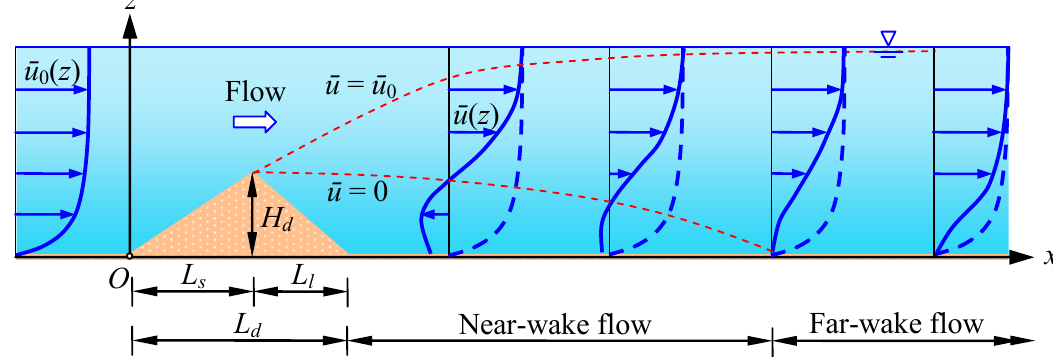
Figure 1. Conceptual sketch of flow over an isolated dunal bedform.